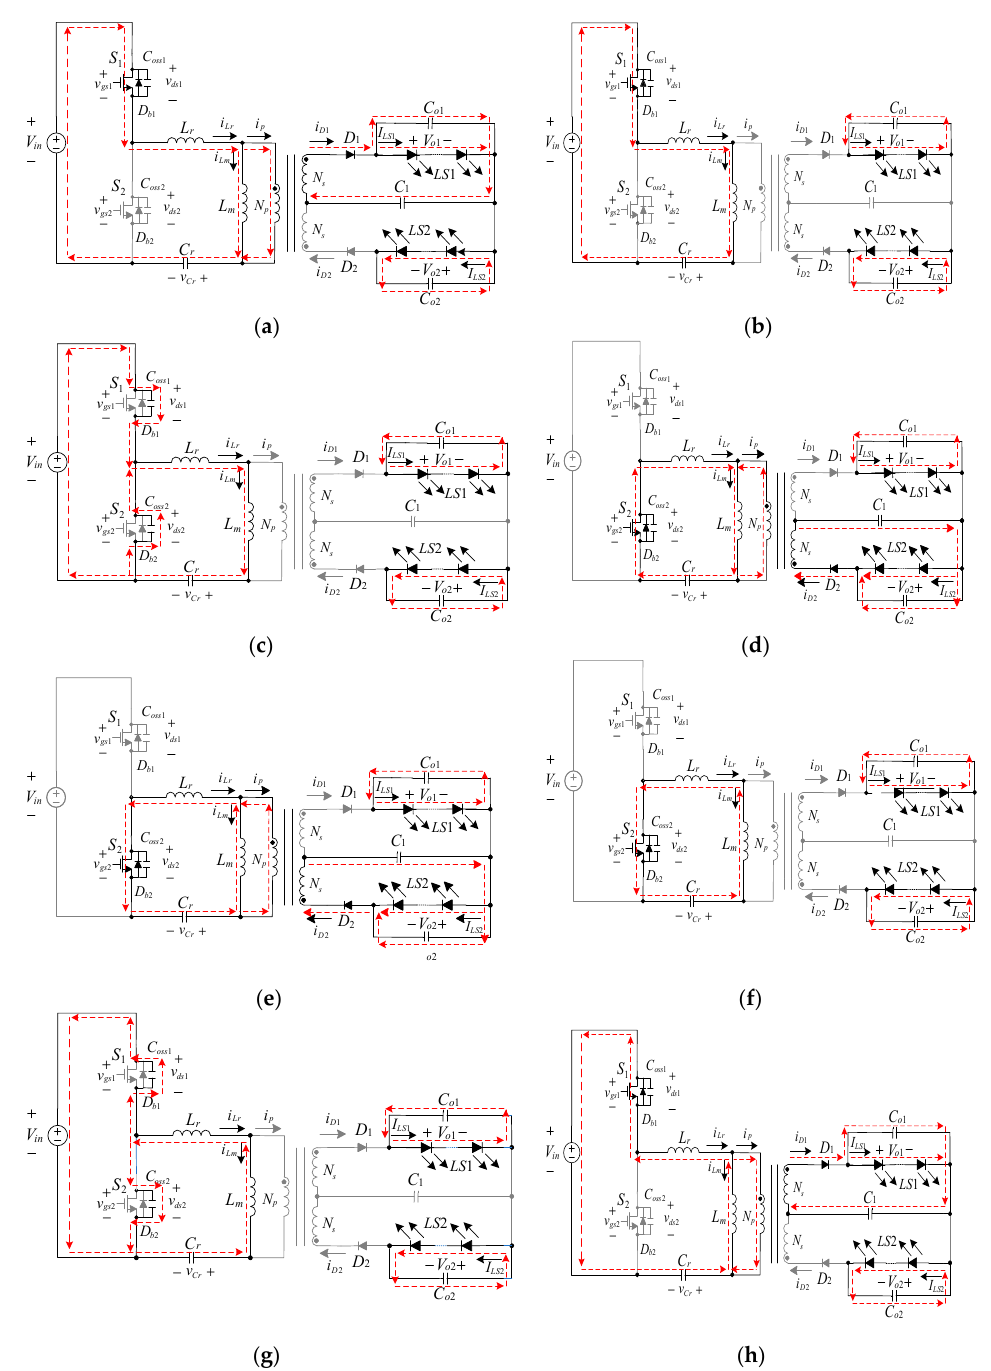
Figure 4. Operating circuits over one switching period: ( a ) state 1; ( b ) state 2; ( c ) state 3; ( d ) state 4; ( e ) state 5; ( f ) state 6; ( g ) state 7; ( h ) state 8.